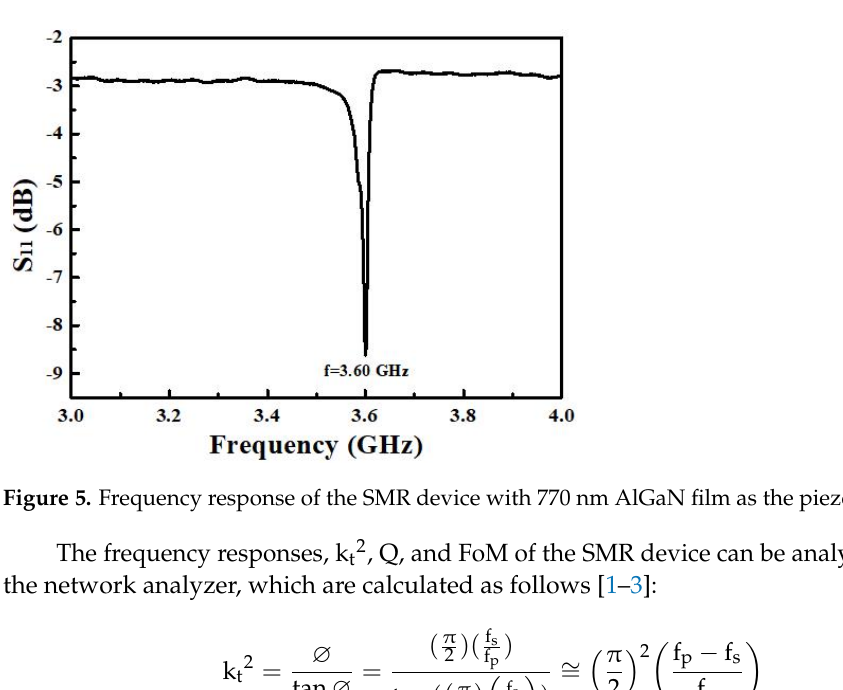
return loss of the SMR device are 3.6 GHz and − 8.62 dB, respectively.